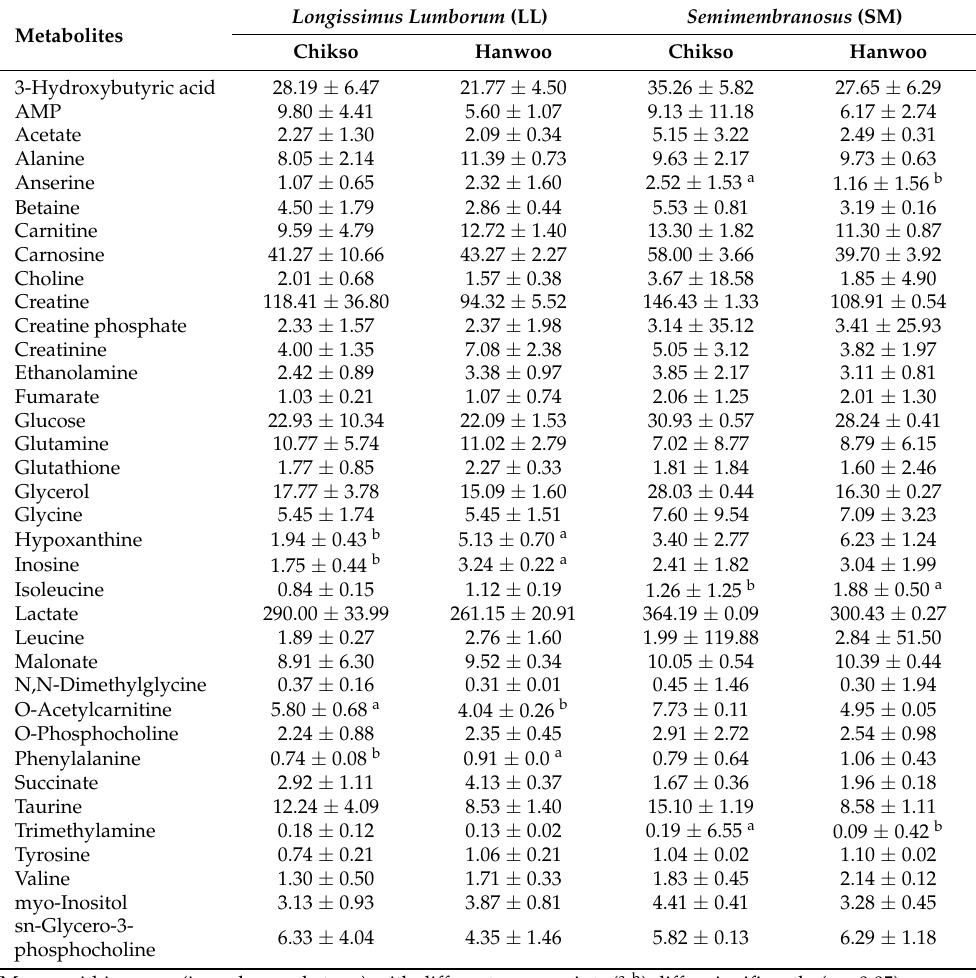
Figure 1. Representative 1 H NMR spectrum of beef LL muscles from Chikso and Hanwoo. Peaks arising from some common metabolites in the spectrum. Table 4. Concentration (mM/kg) of metabolites in the cooked LL and SM muscles from Chikso and Hanwoo under identical rearing